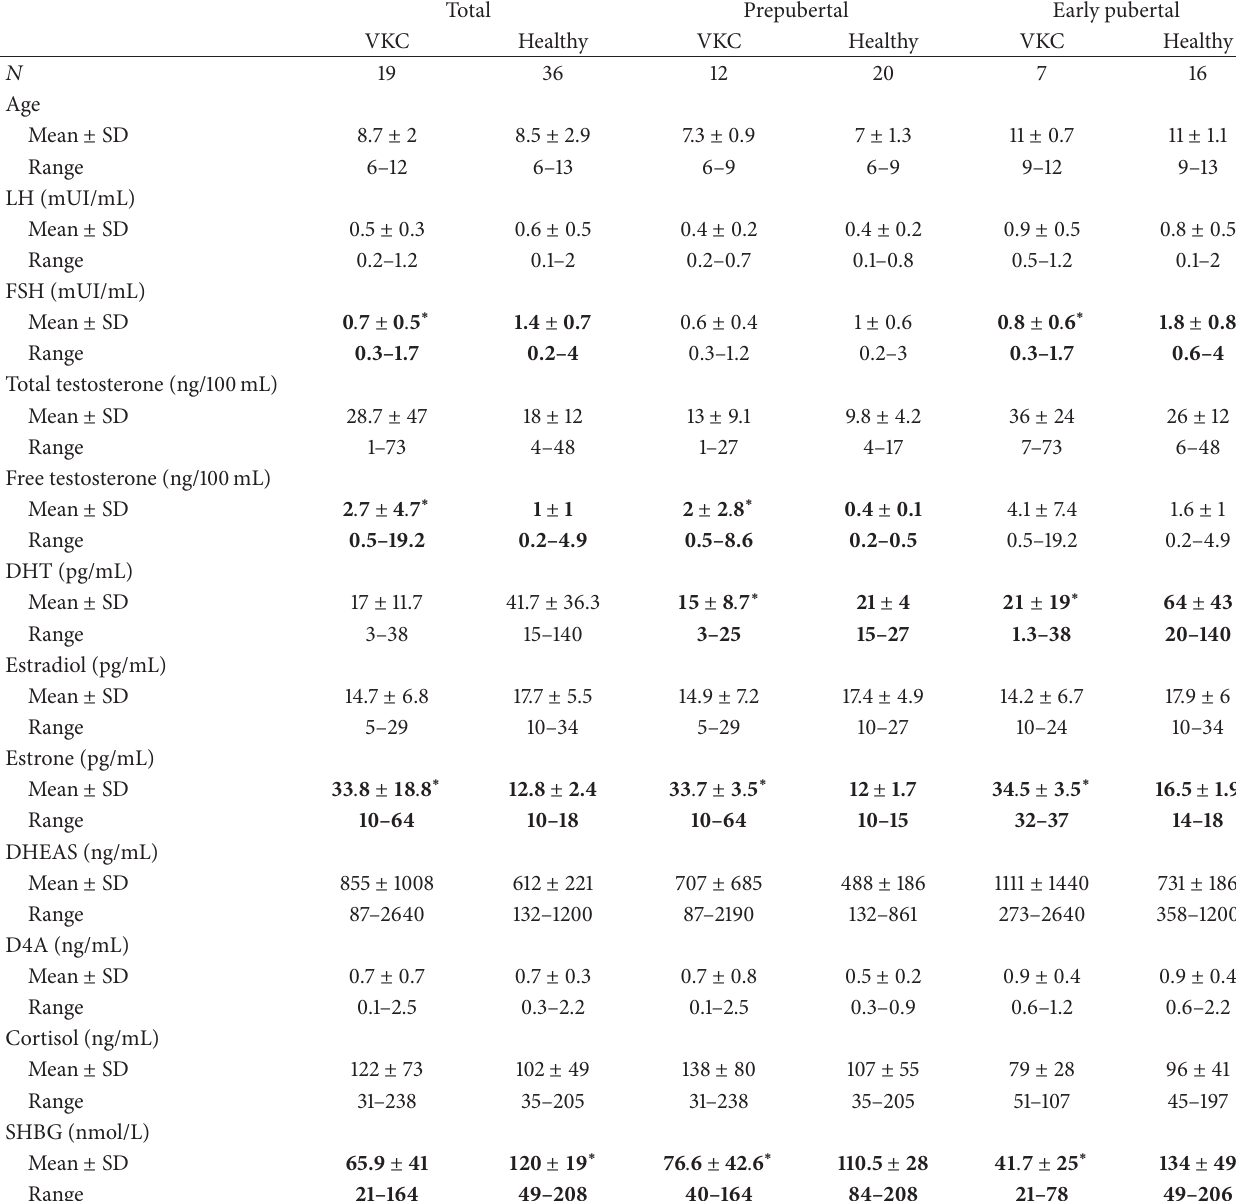
Table 2: Sex hormones serum levels in active VKC and healthy